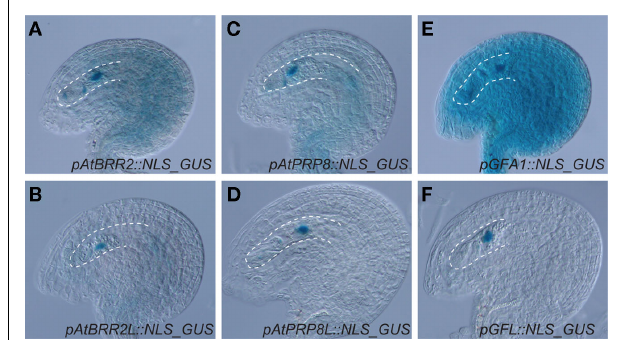
FIGURE 2 | Expression patterns of three pre-mRNA splice factor encoding gene pairs in the ovule. Recent work in the authors’ laboratory indicate that AtBRR2, AtPRP8, and GFA1 are encoded by genes (At1g20960, At1g80070 and At1g06220, respectively) expressed in sporophytic and gametophytic tissue (A,C,E) , but also by a gene copy, AtBRR 2 L (At2g42270), AtPRP 8 L (At4g38780), and GFL (At5g25230) that is preferentially active in the female gametophyte (B,D,F) .The micropylar half of the female gametophyte is in focus and encircled by a dottet